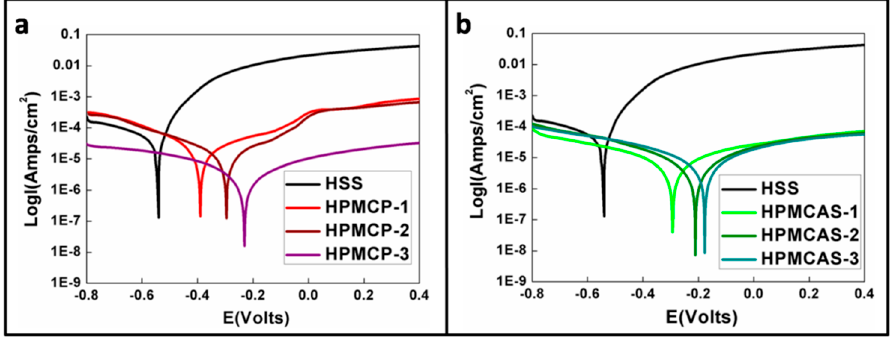
Figure 5. Polarization curve of ( a ) HPMCP with varying thickness; ( b ) HPMCAS with varying thickness. Table 3. EIS fitting results and contact angles of HPMCP and HPMCAS coated electrodes.